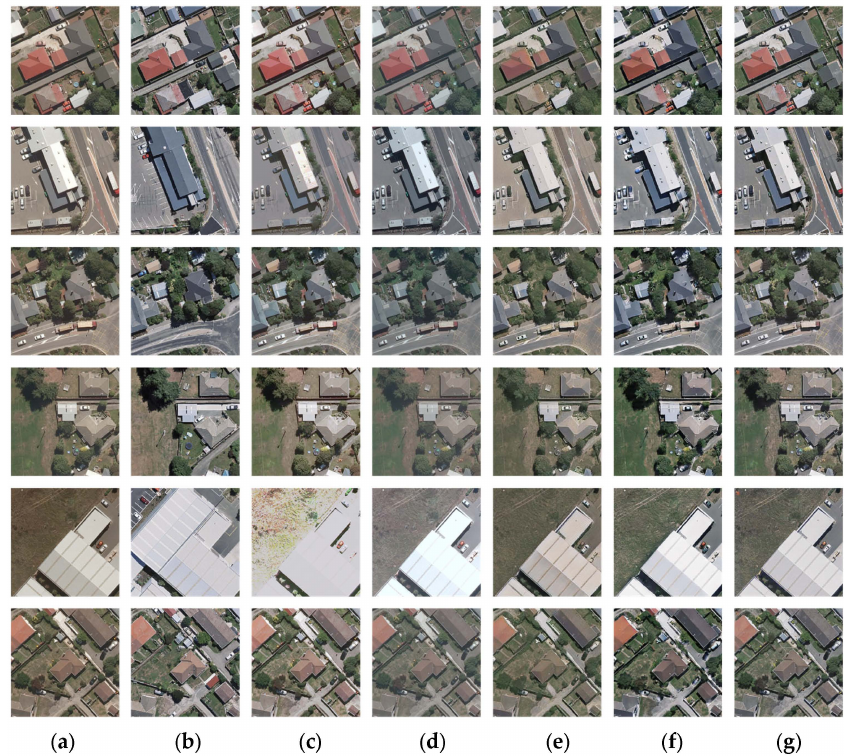
Figure 6. Image color translation results obtained on the Wuhan University building change detection dataset, ( a ) 2012 image, ( b ) 2016 image, ( c ) HM, ( d ) Reinhard method, ( e ) DRIT, ( f ) UNIT, and ( g ) CycleGAN.